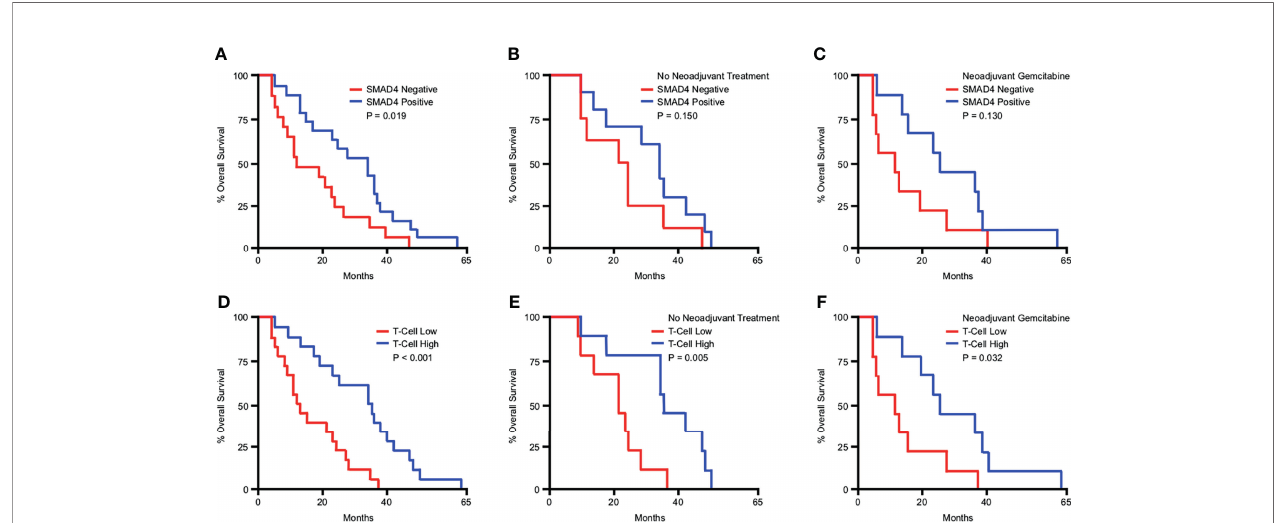
FIGURE 2 | SMAD4 expression and increased T-cell in fi ltration predict for improved overall survival in PDAC patients. Kaplan-Meier curve indicating months of overall survival following surgical resection for a cohort of 36 patients arranged by: (A) SMAD4 status determined by immunohistochemistry, (B) SMAD4 status for only the patients that received no neoadjuvant therapy, (C) SMAD4 status for only the patients that received neoadjuvant Gemcitabine-based chemotherapy, (D) Patients above or below the median value for CD3+ T-cells per high power fi eld, (E) T-cells status for only the patients that received no neoadjuvant therapy, (F) T-cells status for only the patients that received neoadjuvant Gemcitabine-based